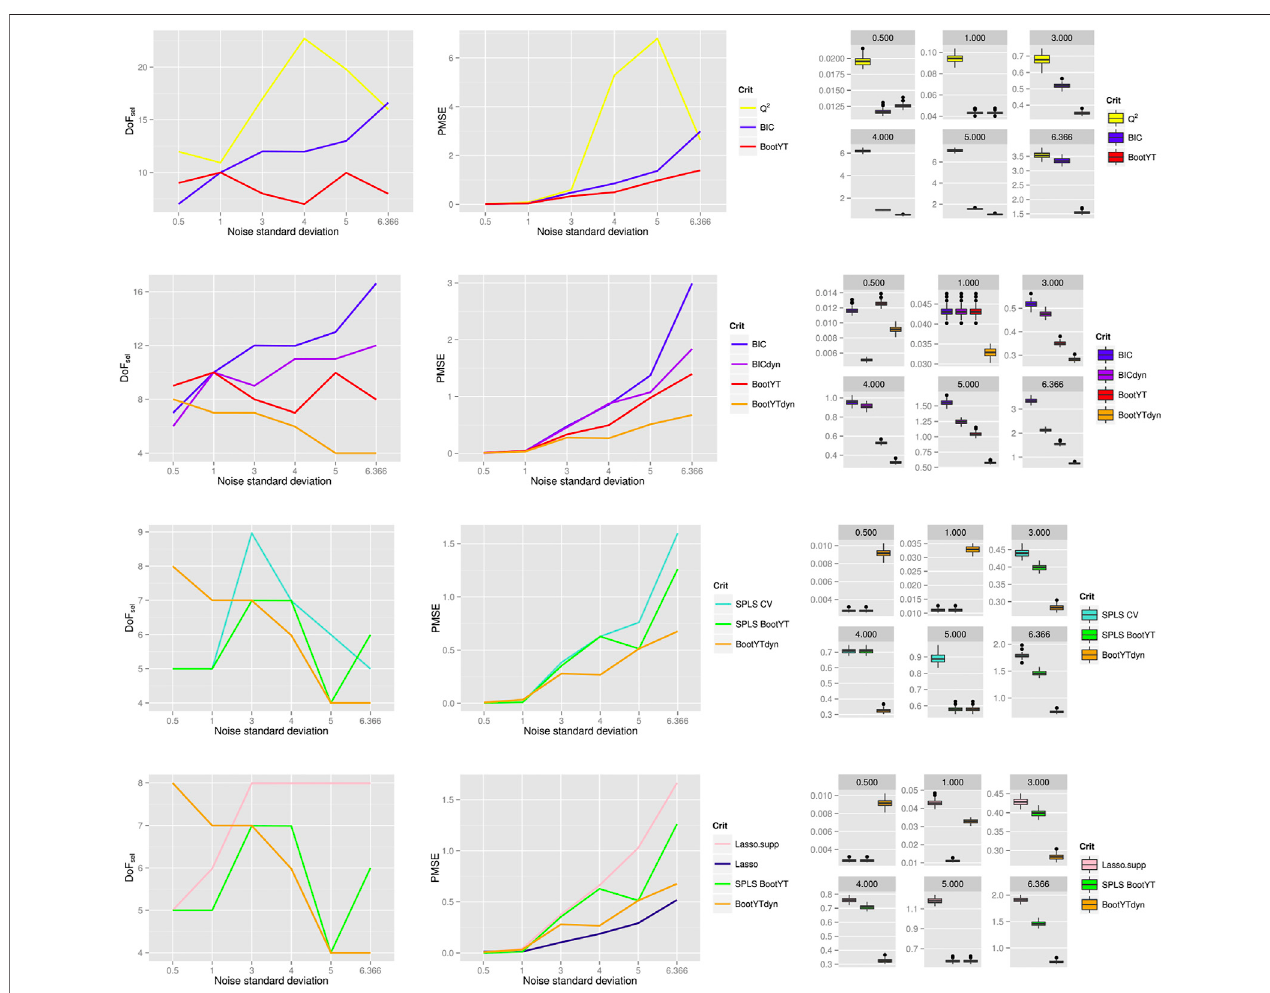
FIGURE 3 | From left to right: DoF of the extracted sparse models, PMSE based on y test without noise, and boxplots of 10-CV MSE based on y without noise.